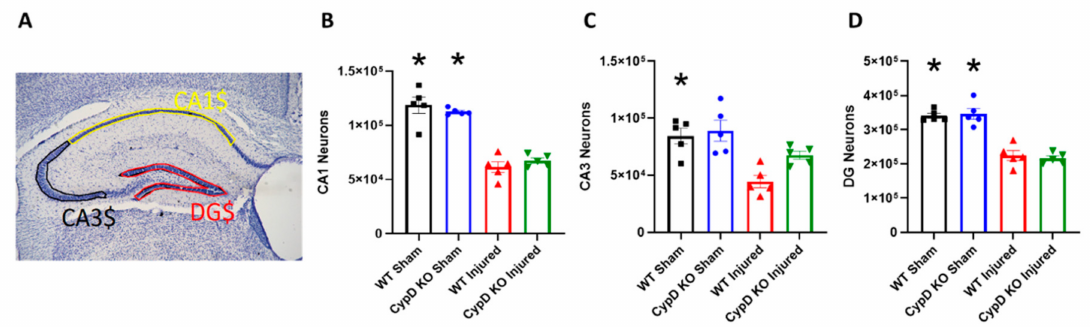
Figure 2. CypD knockout mitigates TBI-related CA3 neuronal loss. ( A ) Outline of hippocampal sub-regions, DG, CA3, and CA1. ( B ) Injury significantly decreased the number of CA1 neurons in both WT and CypD KO mice. ( C ) There was a significant decrease in CA3 neurons after TBI in WT mice. However, CypD knockout protected CA3 neurons from injury-induced cell loss. ( D ) TBI resulted in a significant decrease of DG neurons in both WT and CypD KO mice. * p < 0.003 compared to injured counterpart in each genotype. Data points represent group mean ± SEM. N = 5/group.